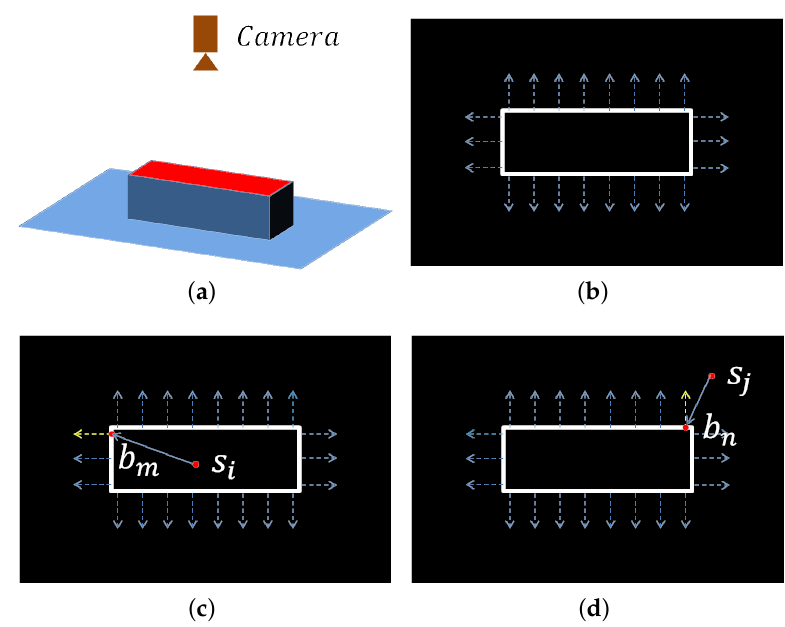
Figure 4. Illustration of how to distinguish foreground points with background points. ( a ) a cuboid on the plane and the camera is above the object; ( b ) the boundary points of the object (white points) and the gradient directions (blue dotted lines); ( c ) for a foreground point s i on the object and a boundary point b m , the angle between the direction of b m (yellow dotted line) and the vector from s i to b m is less than 90 ◦ ; ( d ) for a background point s j and boundary point b n , the angle is larger than 90 ◦ . This difference is used to distinguish foreground points with background